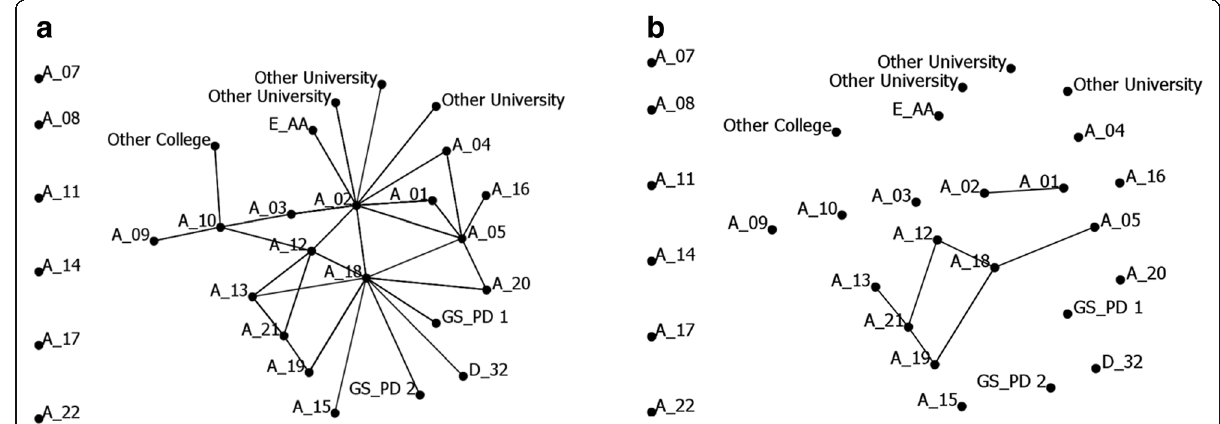
Fig. 2 a All-encompassing network in unit A. b Discussion network of teaching issues related to promotion and tenure in unit